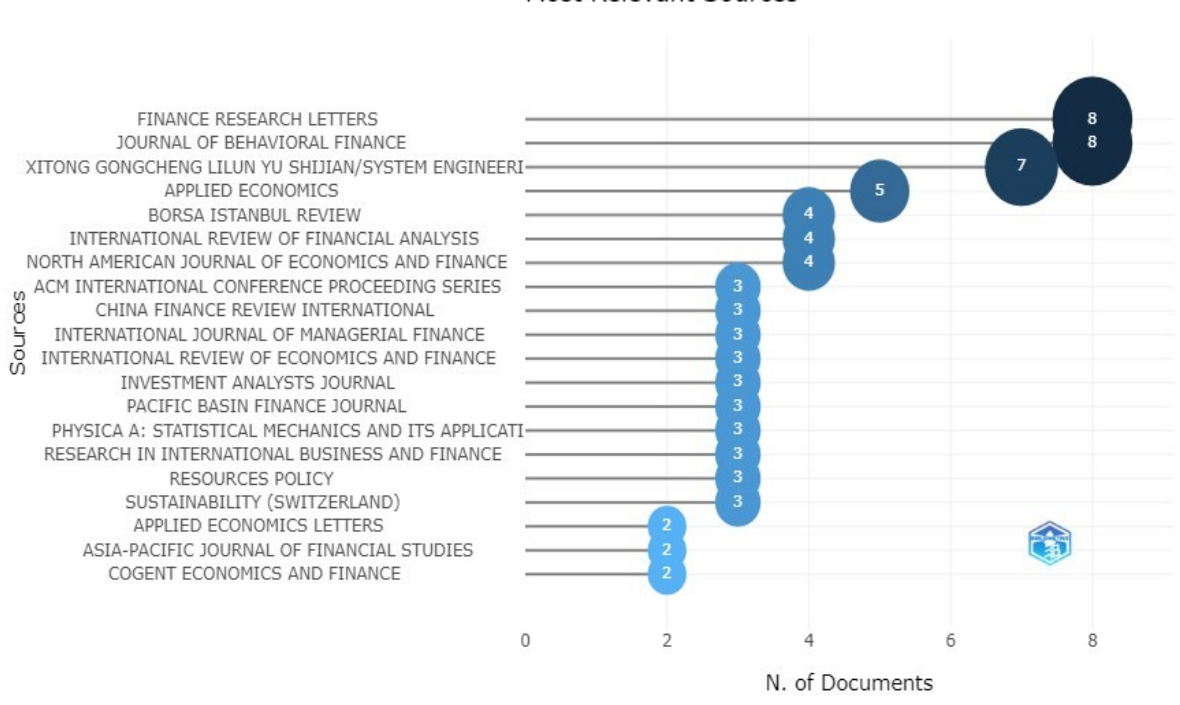
Figure 6. Most relevant sources.